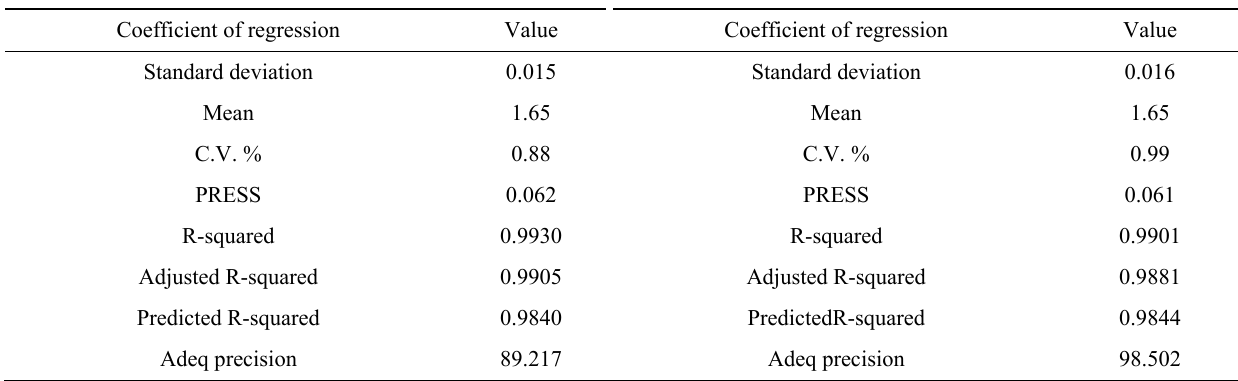
Table 13 Values of coefficient for full and modified quadratic models from ANOVA